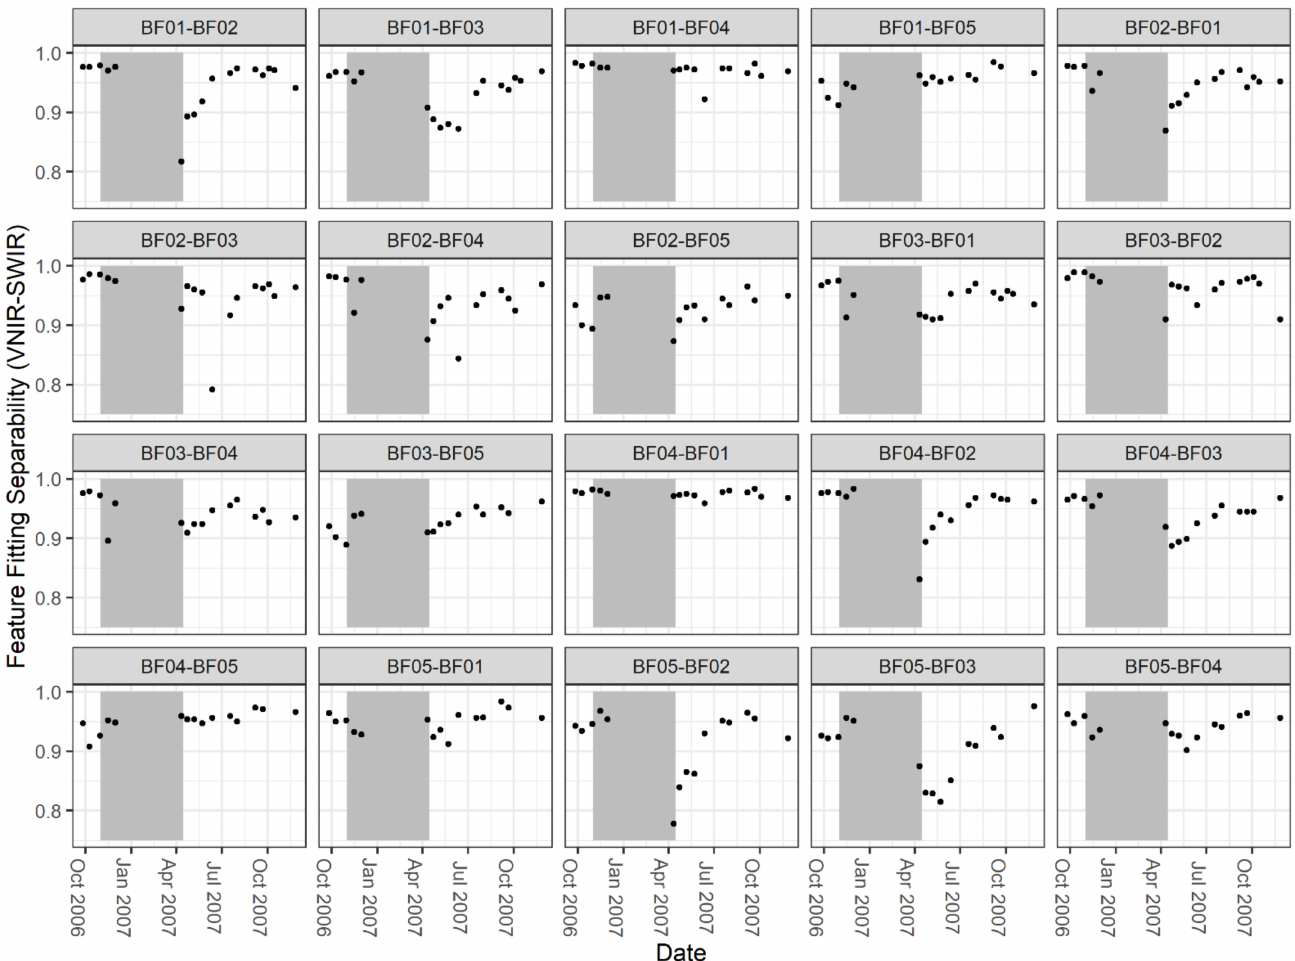
Figure 8. Feature Fitting (VNIR-SWIR). The grey area is the wet season (1 November 2006 and 1 April 2007). No data is plotted from BF01 and BF02 from June 2007, due to disturbance of ground cover. BF01 D. milanjiana (Jarra grass), BF02 and BF03: B. humidicola (Tully grass), BF04: D. milanjiana (Arnhem grass), and BF05: D. eriantha (Pangola